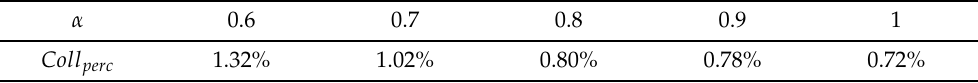
Table 2. Percentage of the total vehicles that are located inside BCZ with FFR technique.